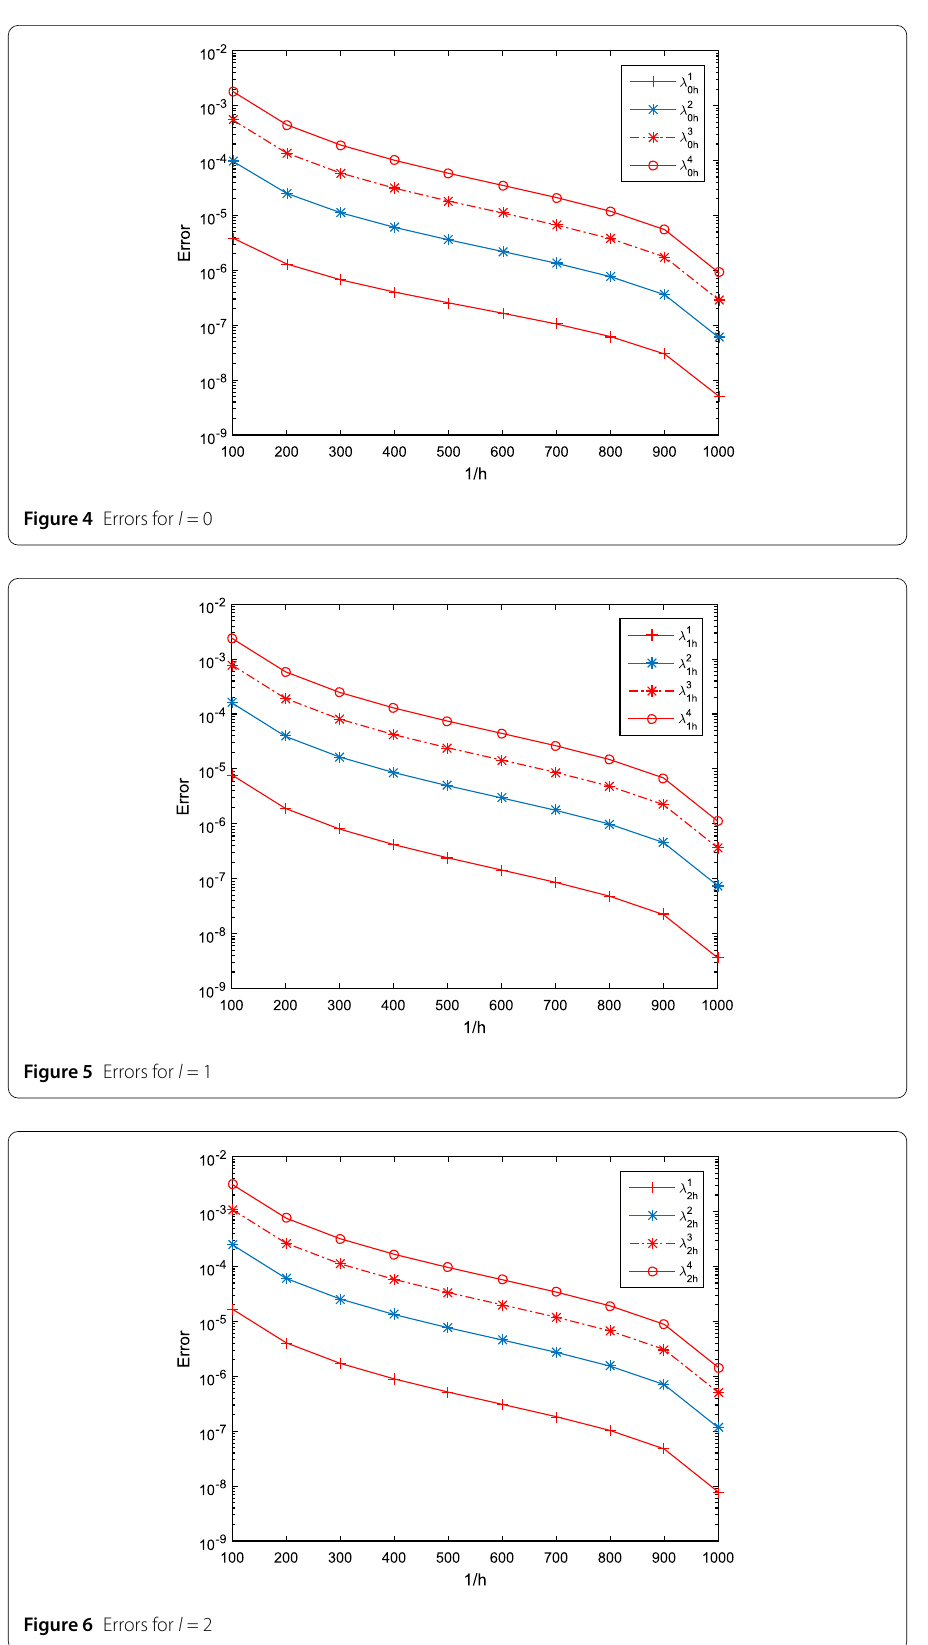
Figure 6 Errors for l =